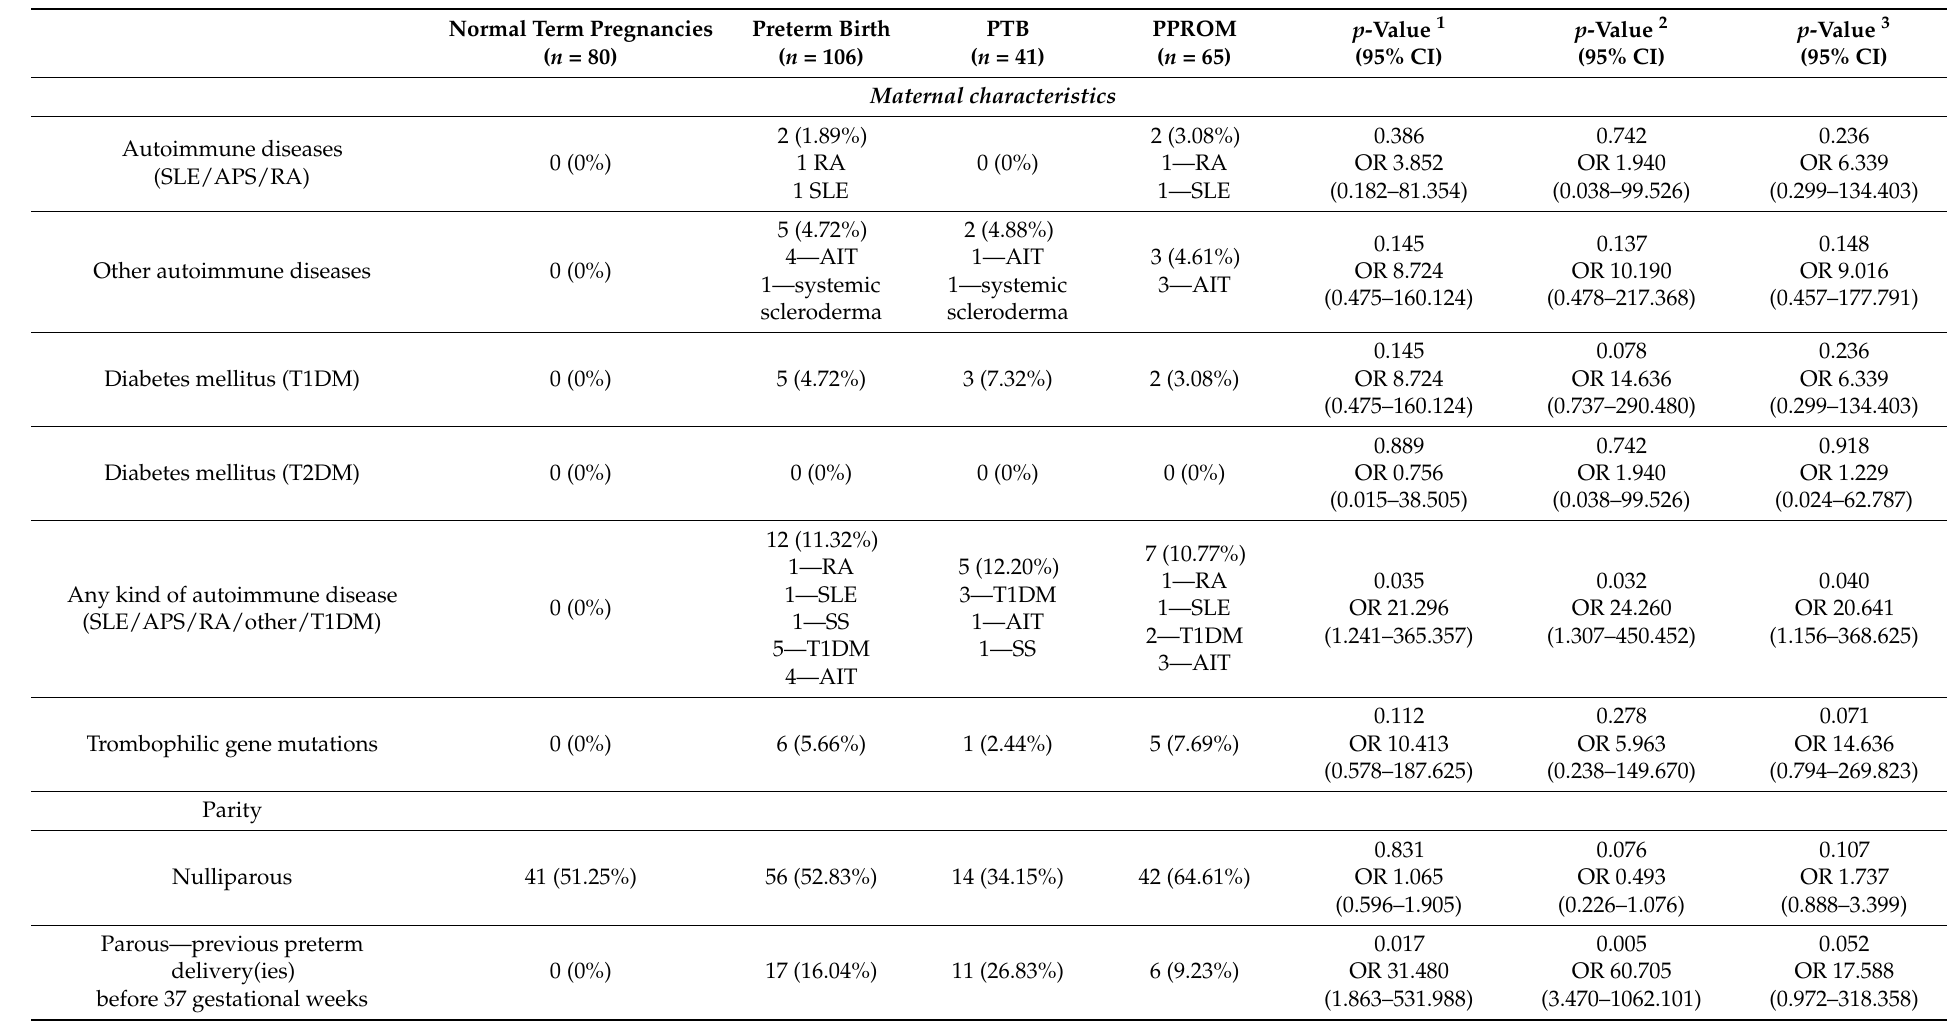
Table 1. Clinical characteristics of the cases (preterm birth before 37 gestational weeks) and the